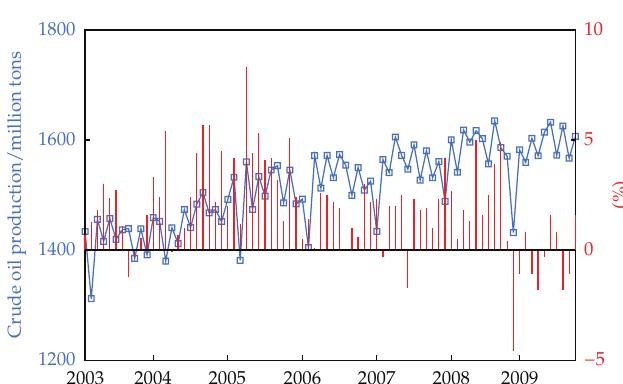
Figure 1: The output and the growth rate of crude oil in